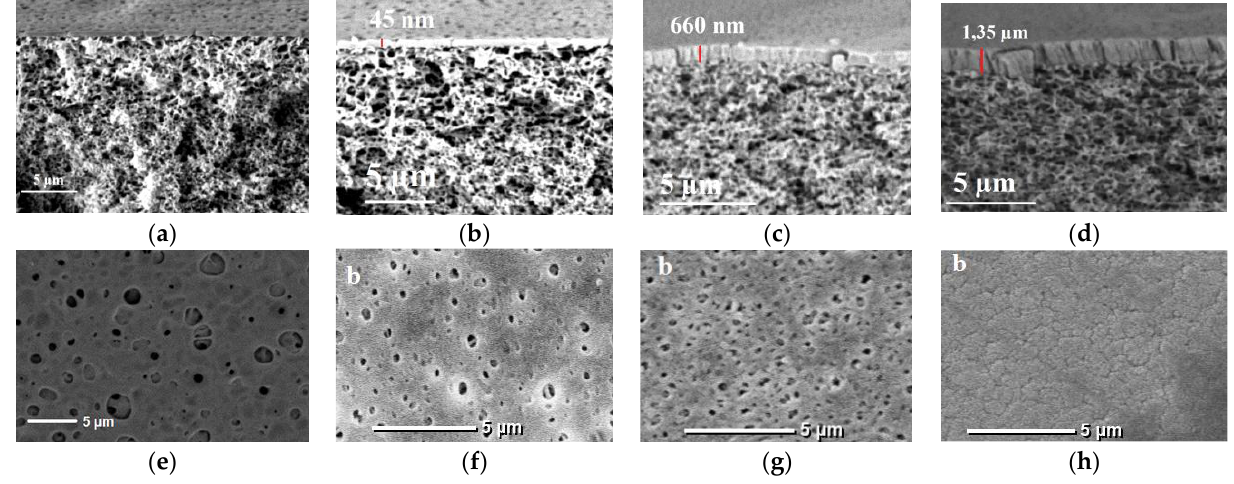
Figure 4. SEM images of the cross-section structure ( a – d ) and selective layer surface ( e – h ) of initial PSf membrane M 0 ( a , e ), and modified M 1 ( b , f ), M 2 ( c , g ), and M 3 ( d , h ) membranes.